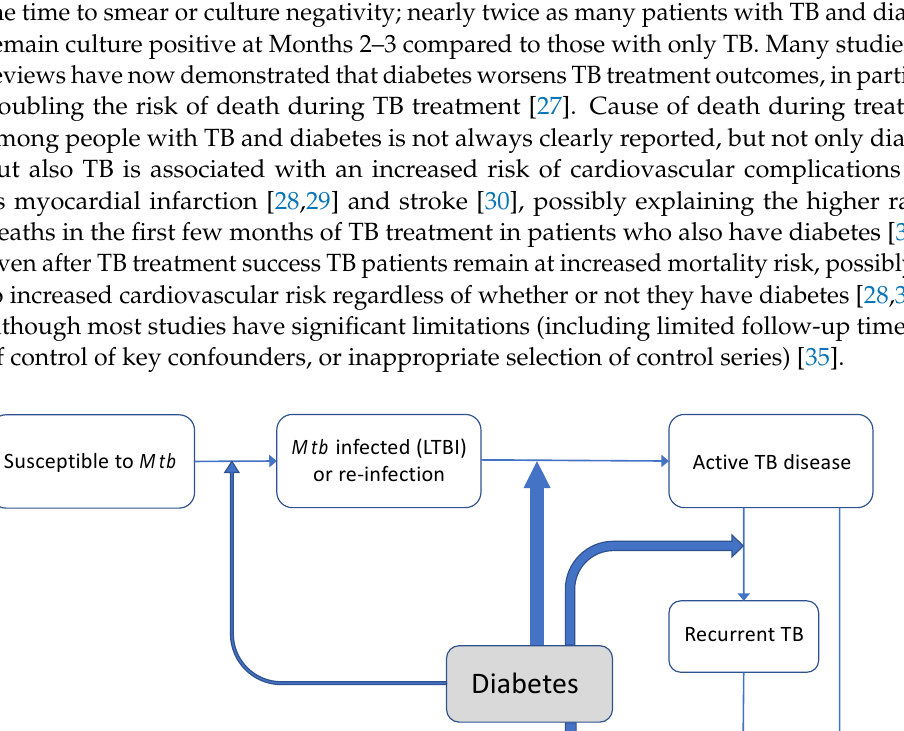
Figure 1. Effects of diabetes on natural history of tuberculosis. Natural history of TB, with the impact of concomitant diabetes at various points on this pathway depicted. The width of lines represents current understanding of magnitude and certainty of evidence (see references [18–20,24,27] in text for evidence for and magnitude of possible relationships between diabetes and TB susceptibility, TB disease and prognosis).